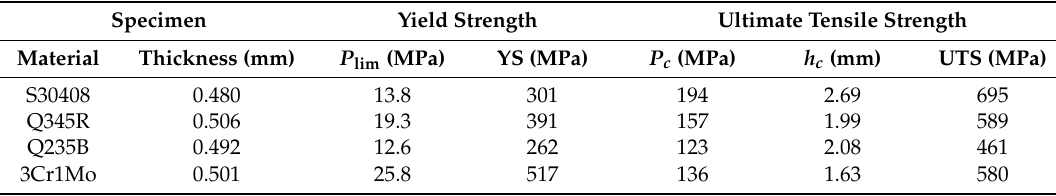
Figure 13. The HBT curves of four different materials. Table 2. The data for strength estimation.